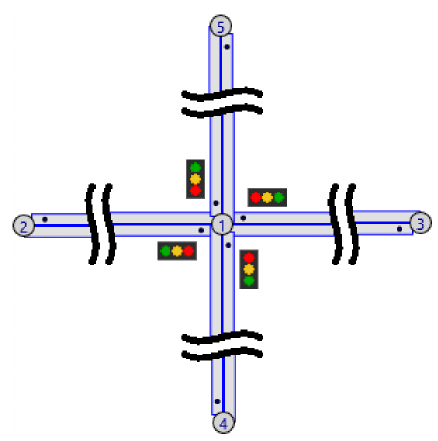
Figure 5. Simulated road intersection.